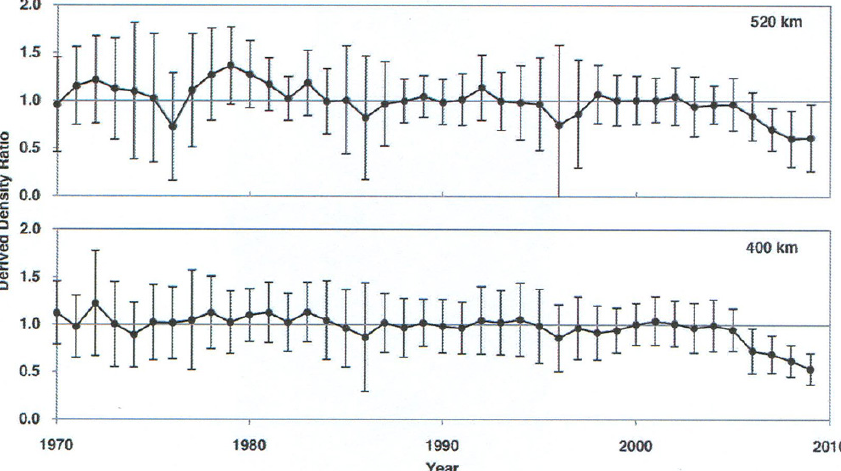
Fig. 3. Observed NRLMSISE-00 density ratios within the altitude bins of 400 and 520km, 1970–2009. Adopted from Saunders et al. (2011).